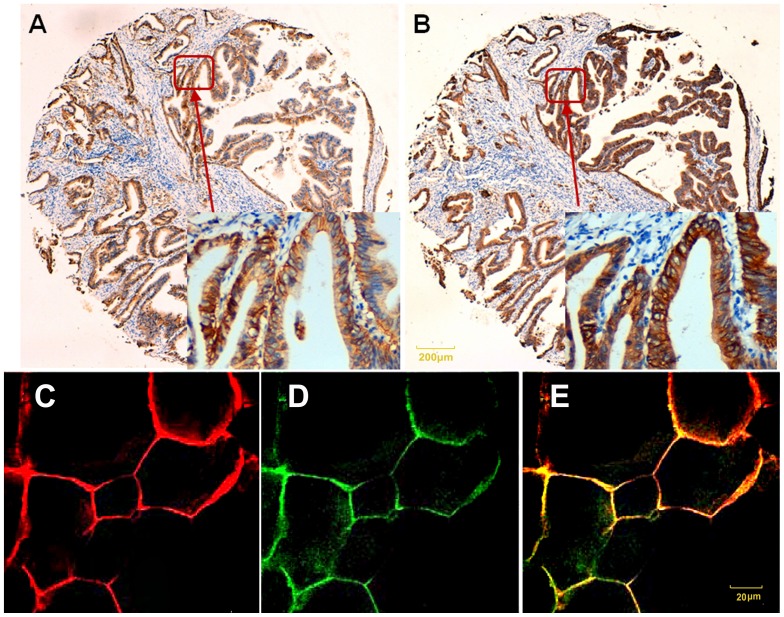
Correlation between flotillin2 and erbB2 expression, flotillin2 co-localize with erbB2 at the plasma membrane.Representative protein expression of (A) flotillin2 and (B) erbB2 in a tissue microarray core was taken from a gastric carcinoma. SGC-7901 gastric cancer cells were stained with anti-erbB2, anti-flotillin2 antibody respectively, the stained antibody was visualized by TRITC/FITC-conjugated goat anti-mouse IgG antibody, and the slides were then examined by a confocal laser scanning microscope. TRITC (erbB2) is shown as red (C), FITC (flotillin2) as green (D), and the merge of green and red becomes yellow (E).